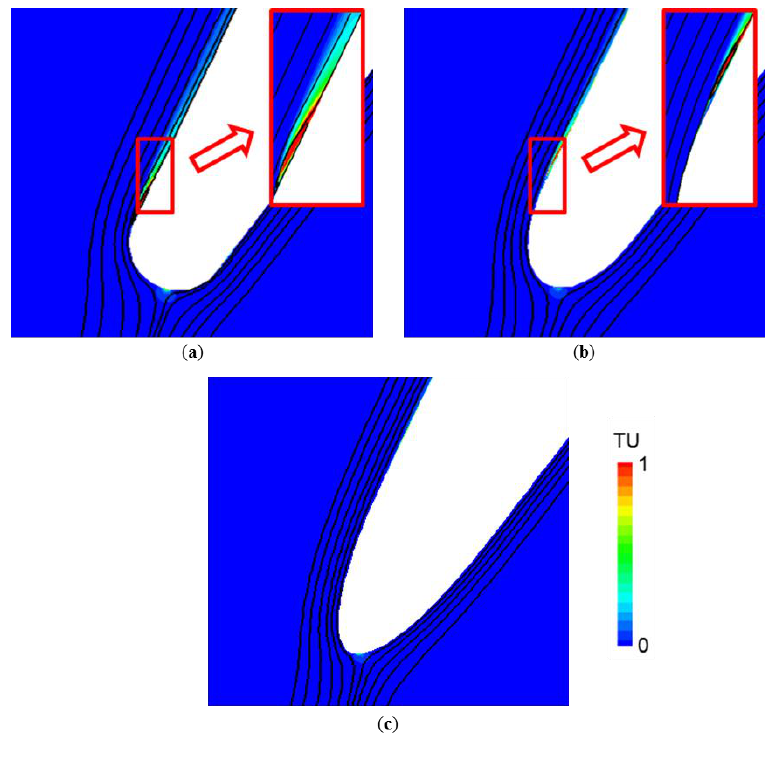
Figure 17. Streamlines and turbulence intensity distributions at high inlet turbulence intensity (α = 58°); ( a ) circular LE; ( b ) elliptical LE; ( c ) continuous-curvature